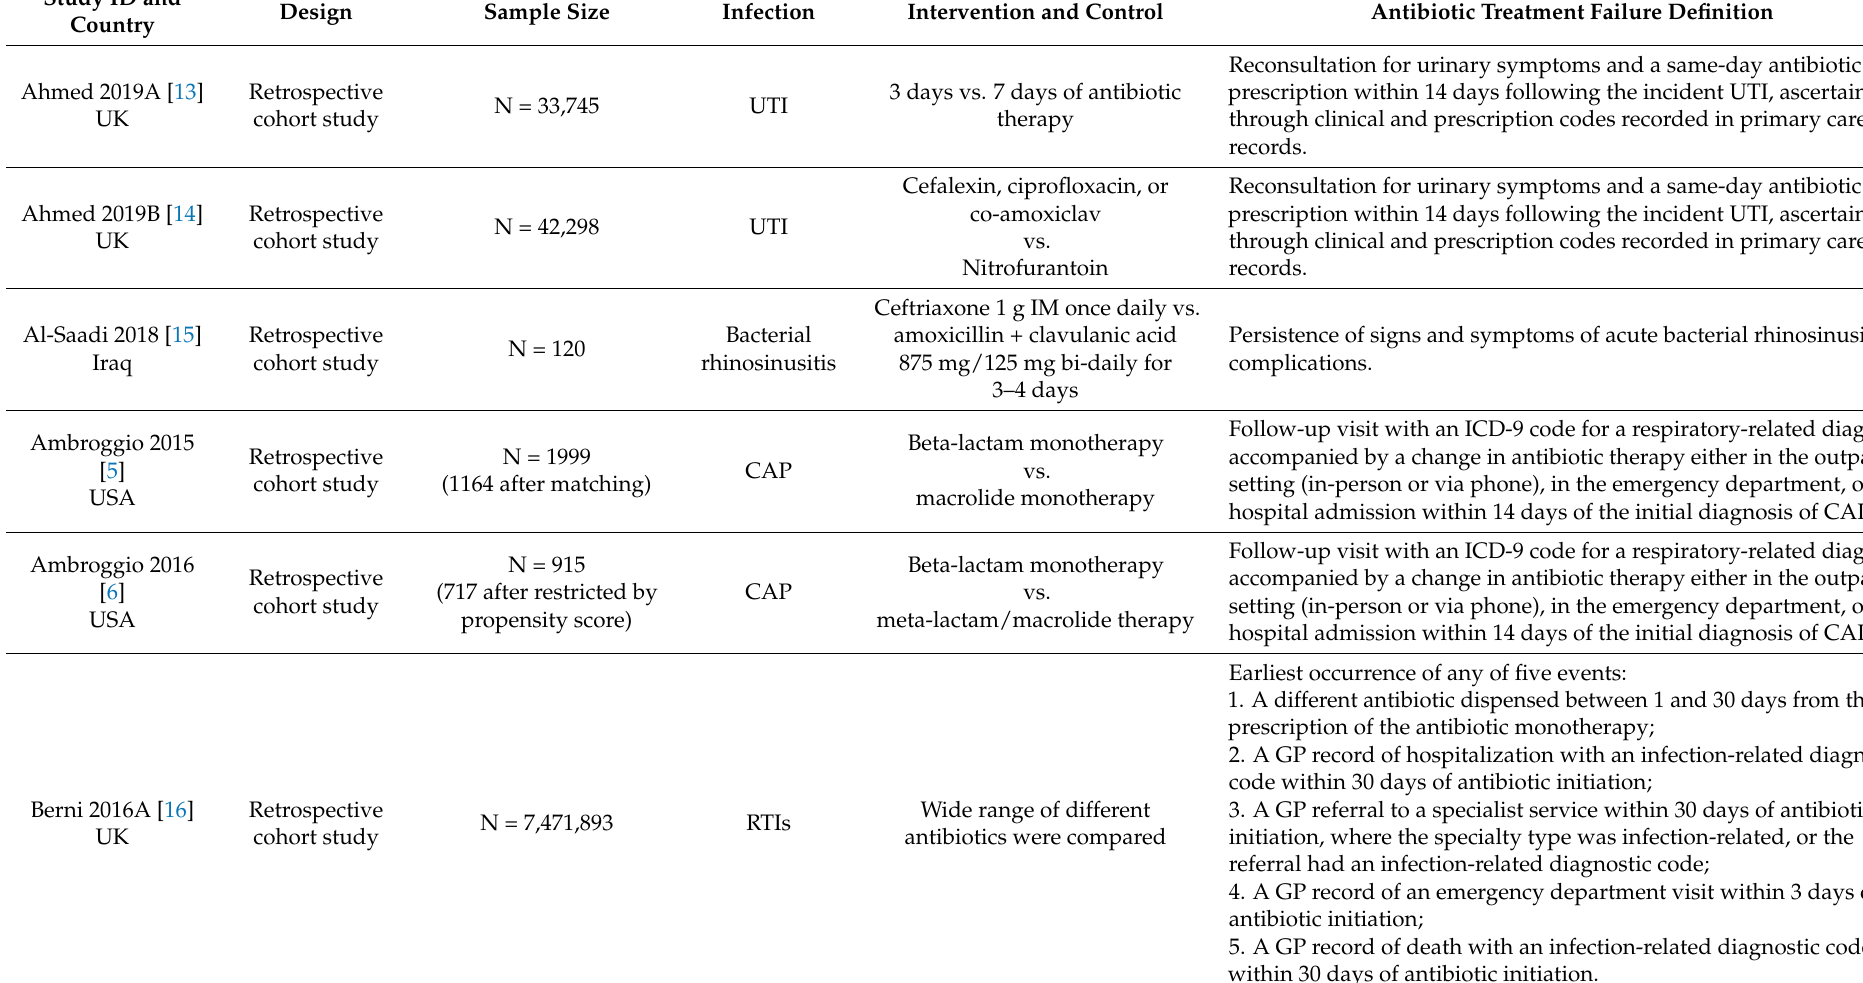
Table 1. Summary of included